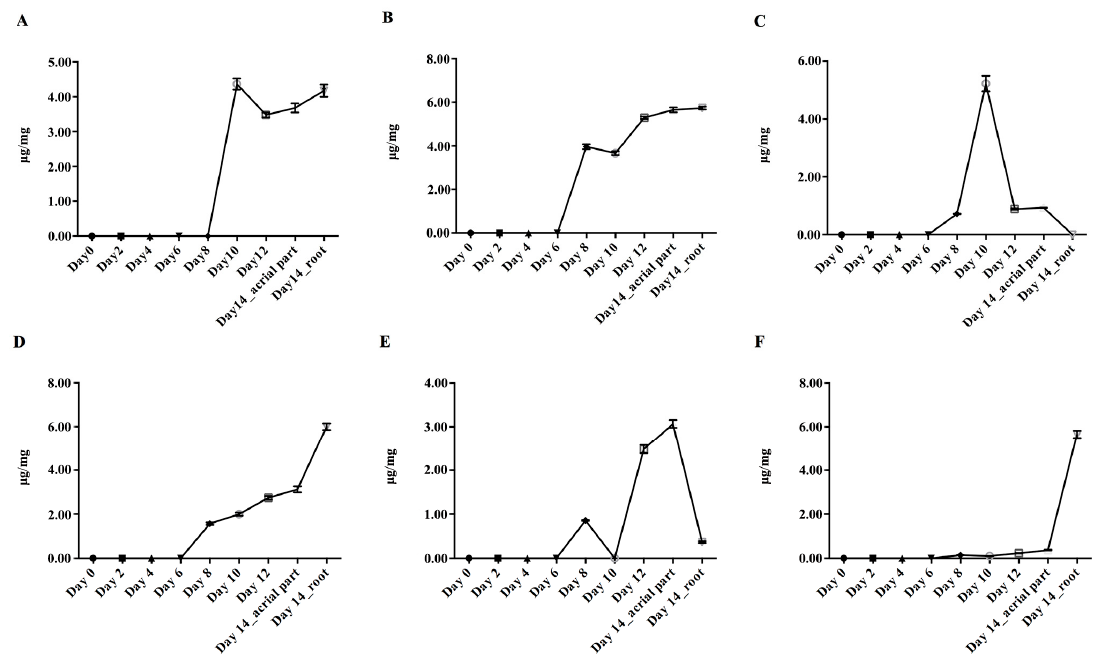
Figure 4. The accumulation patterns of flavonoids in S. baicalensis from seed germination to the true leaves coming out. ( A ): Isocarthamidin-7- O - β - D -glucuronide; ( B ): Scutellarin; ( C ): Apigenin-7- O - β - D -glucuronide; ( D ): Baicalin; ( E ): Chrysin-7- O - β - D -glucuronide; ( F ): Wogonoside; The units “ µ g/mg” meant the contents of analytes in per mg of freeze-dried samples.